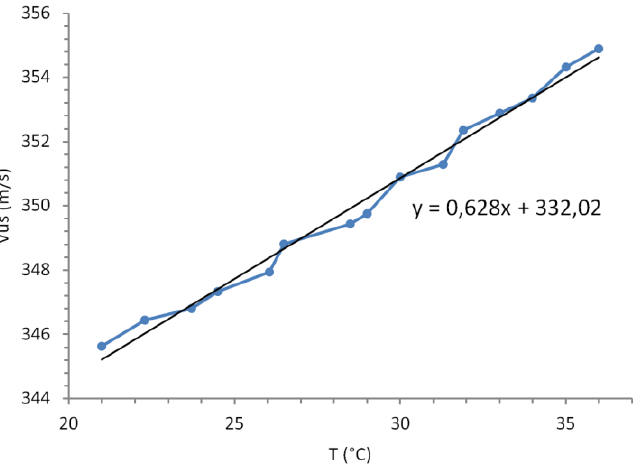
its equation at the following distances: ( a ) 1 m, ( b ) 2 m, ( c ) 3 m.